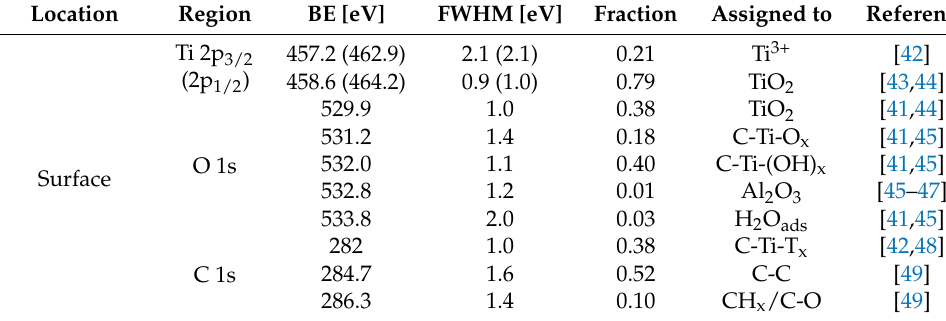
Figure 5. Component peak fitting of XPS spectra for Ti 2 CT x after catalytic thermal decomposition of AP, ( a ) Ti 2p, ( b ) C 1s, and ( c ) O 1s on the surface, and ( d ) Ti 2p, ( e ) C 1s, and ( f ) O 1s in the inner (after 10 s Ar sputtering). Table 2. XPS peak fitting results for Ti 2 CT x after catalyzing AP on the surface and inner locations (after 10 s Ar + sputtering). Numbers in brackets in column 3 are peak locations, and their full widths at half maximum, FWHM, are listed in column 4 in brackets.